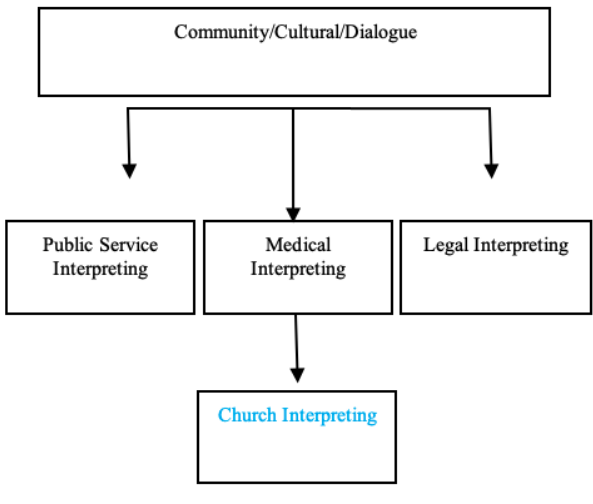
Figure 2: Modified varieties of community interpreting; Source: